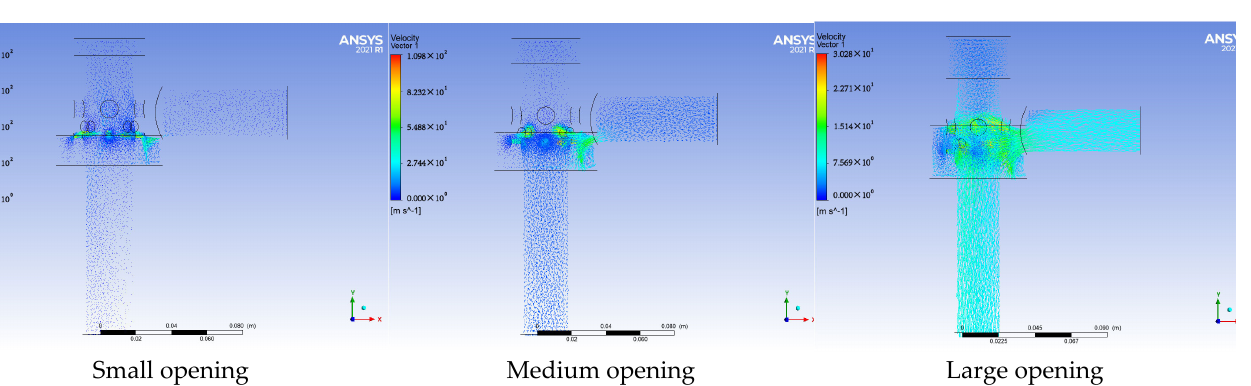
Figure 6. Velocity vector distribution at different openings.